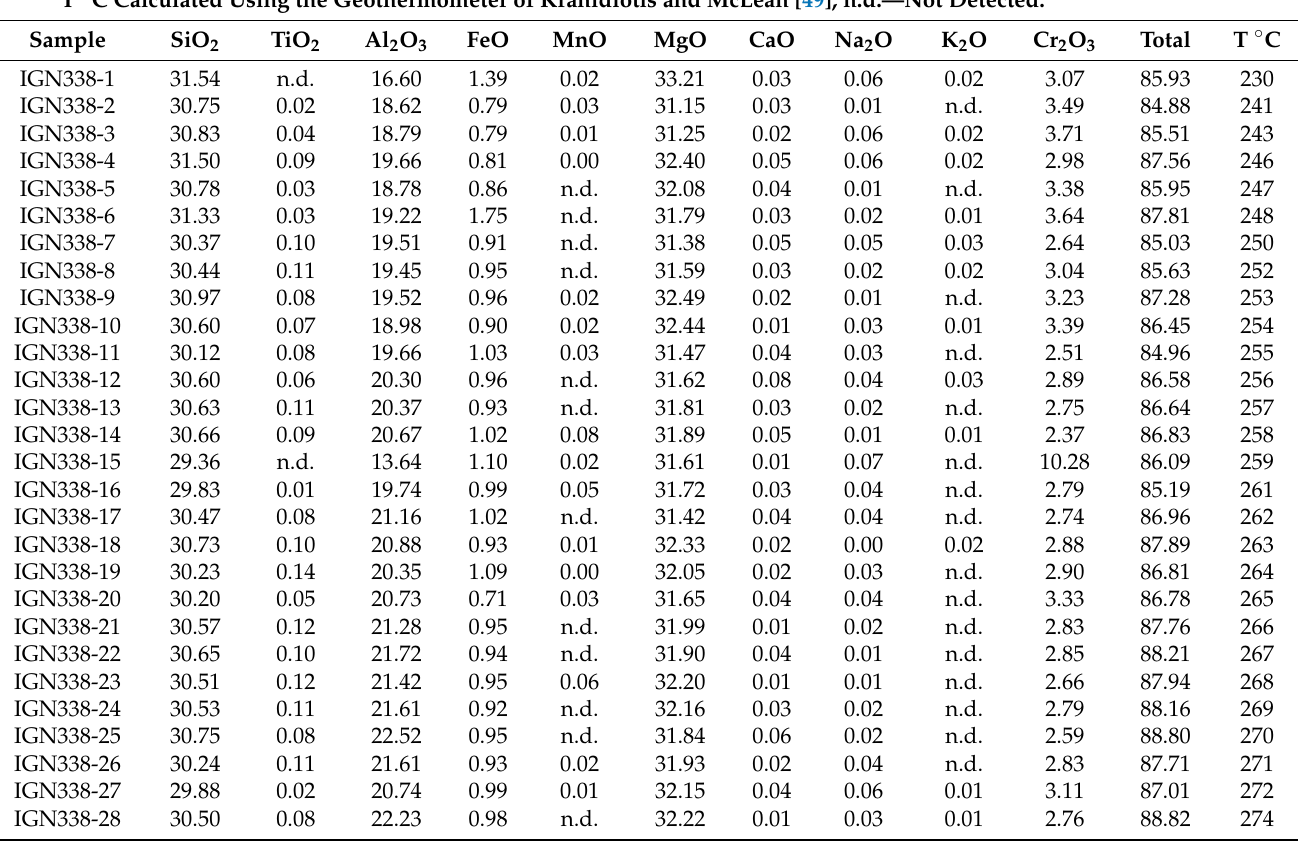
Table 3. Representative analyses of chlorite (wt%) associated with the high-Al chromitite of Sebuku